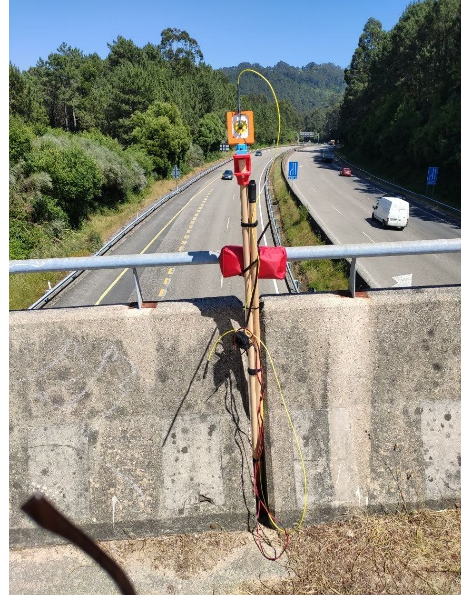
Figure 10. Transmitting antenna placed over the